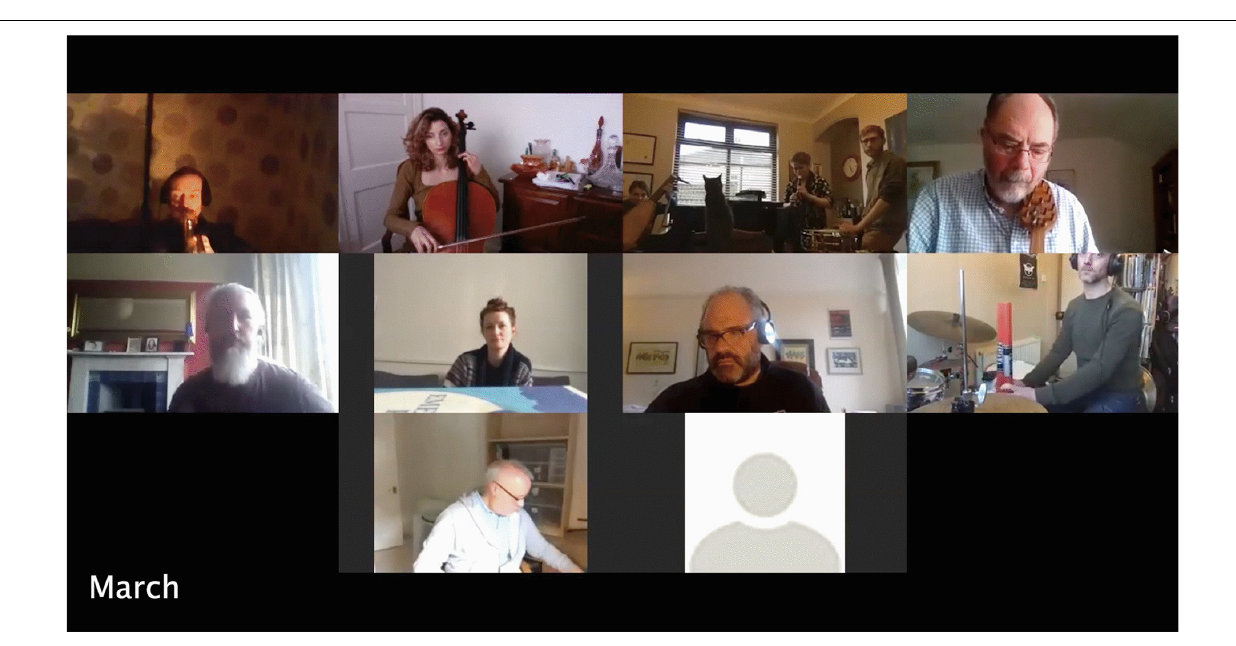
FIGURE 11 | Time-lapse of rehearsals, all photos taken at moments when most participants were in attendance. The Gif version, highlighting musicians’ movement, can be found in the Supplementary Material